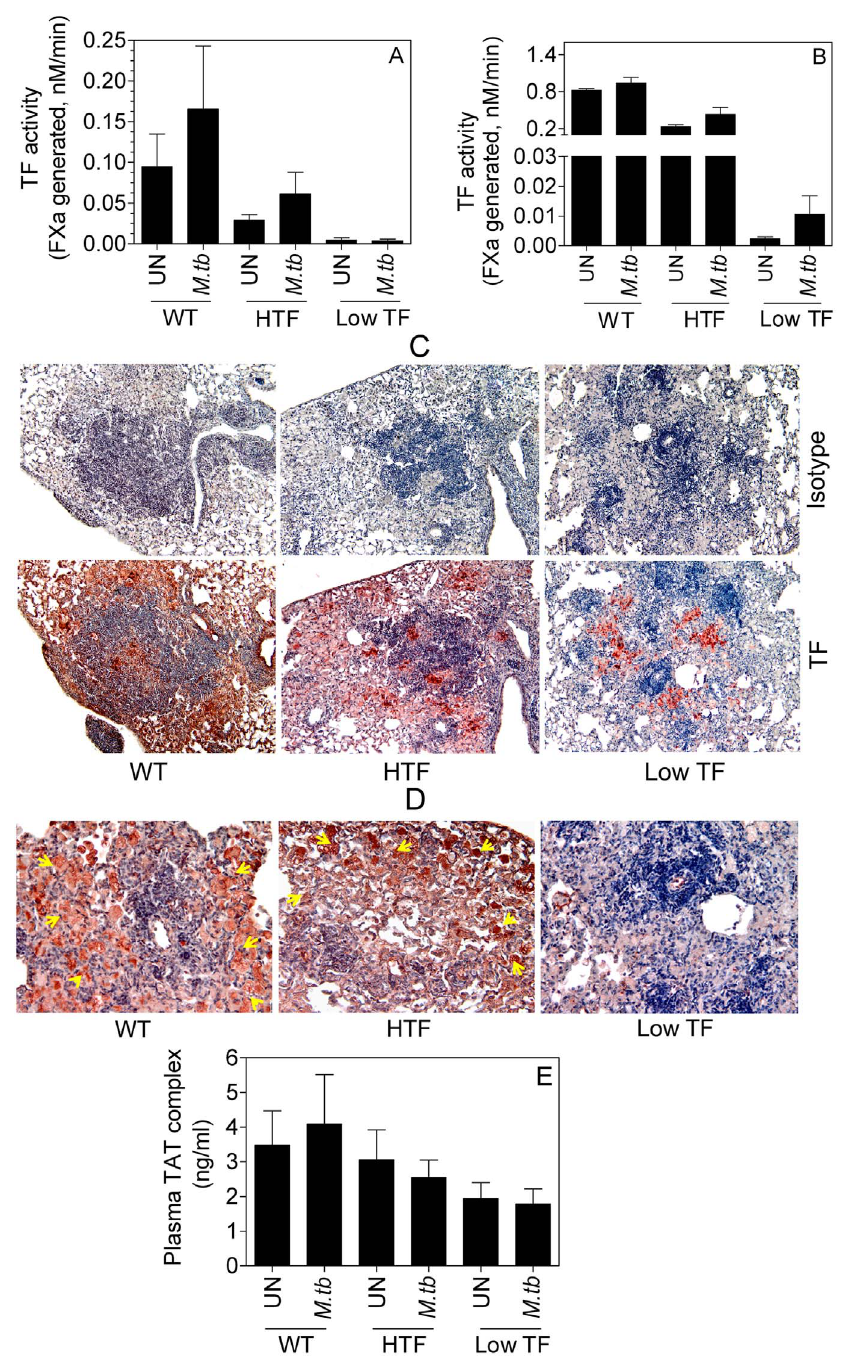
Figure 5. TF expression in alveolar macrophages, lungs, and granuloma upon M.tb infection. Eight weeks post infection, ( A ) alveolar macrophages were harvested from BAL and TF procoagulant activity was measured ( B ) TF activity of the lung homogenates of uninfected and M.tb- infected mice. Data are mean ¡ SEM (n 5 5–14 per group). Immunohistochemical analysis of TF expression ( C ) and fibrin generation ( D ) in the granulomas. ( E ) TAT levels in the plasma. Yellow arrow heads point fibrin staining within the